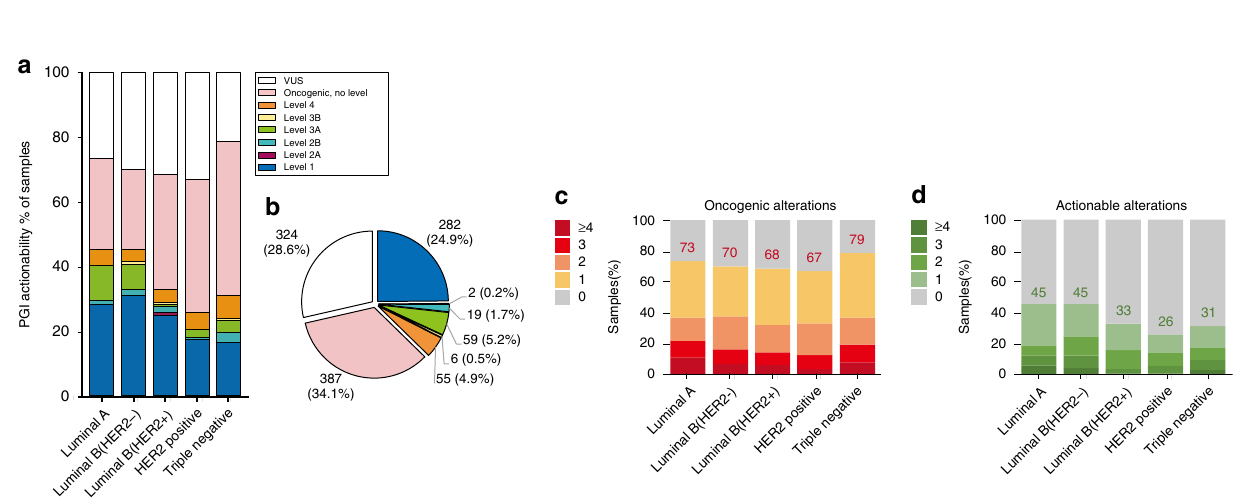
Fig. 5 Actionable and oncogenic alterations revealed by clinical sequencing. a Fractions of alterations annotated based on their clinical actionability according to PGI in different molecular subtypes of breast cancer. b Distribution of breast cancer samples assigned with the level of the most signi fi cant alteration. c Fractions of samples with multiple oncogenic alterations annotated in different molecular subtypes of breast cancer. d Actionable alterations annotated in different molecular subtypes of breast